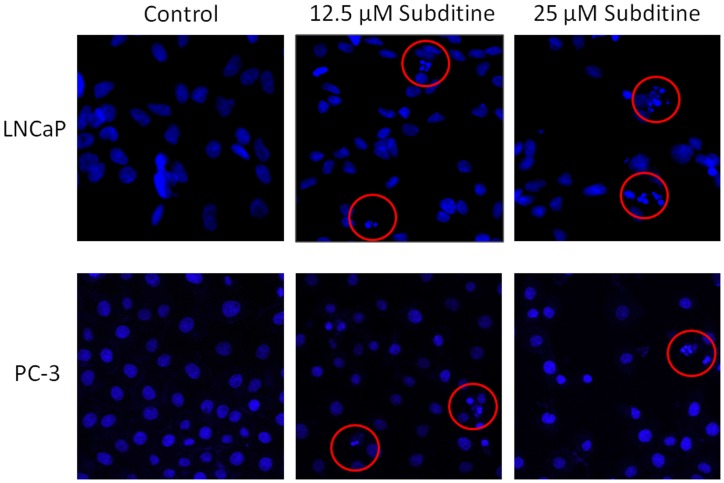
Subditine (1) treatment leads to nuclear DNA fragmentation.LNCaP and PC-3 cells were treated with subditine (1) (12.5 µM and 25 µM) for 24 h. Cells were then fixed and stained with Hoescht 33342 (blue). Red circles indicate DNA shrinkage or fragmentation. Images were captured using Cellomic arrayscan system.